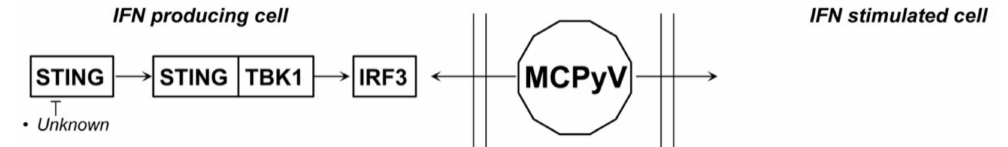
Figure 4. Proteins and miRNAs able to deregulate type I IFNs relevant pathways during MCPyV associated tumorigenesis. Italics represent indirect